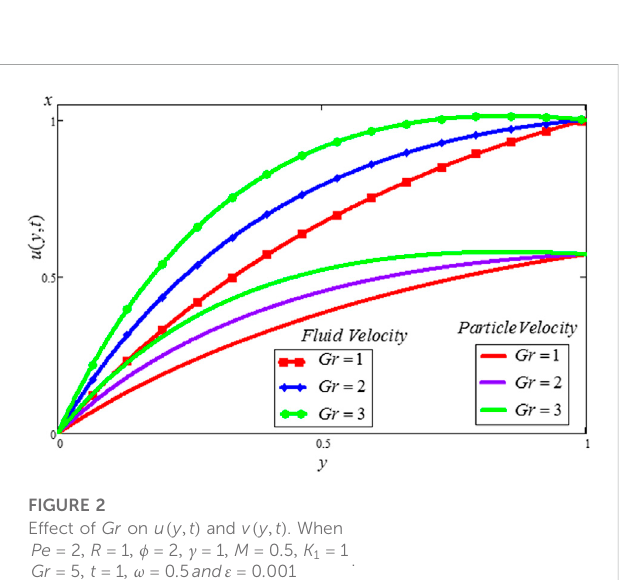
FIGURE 1 Flow con fi guration.